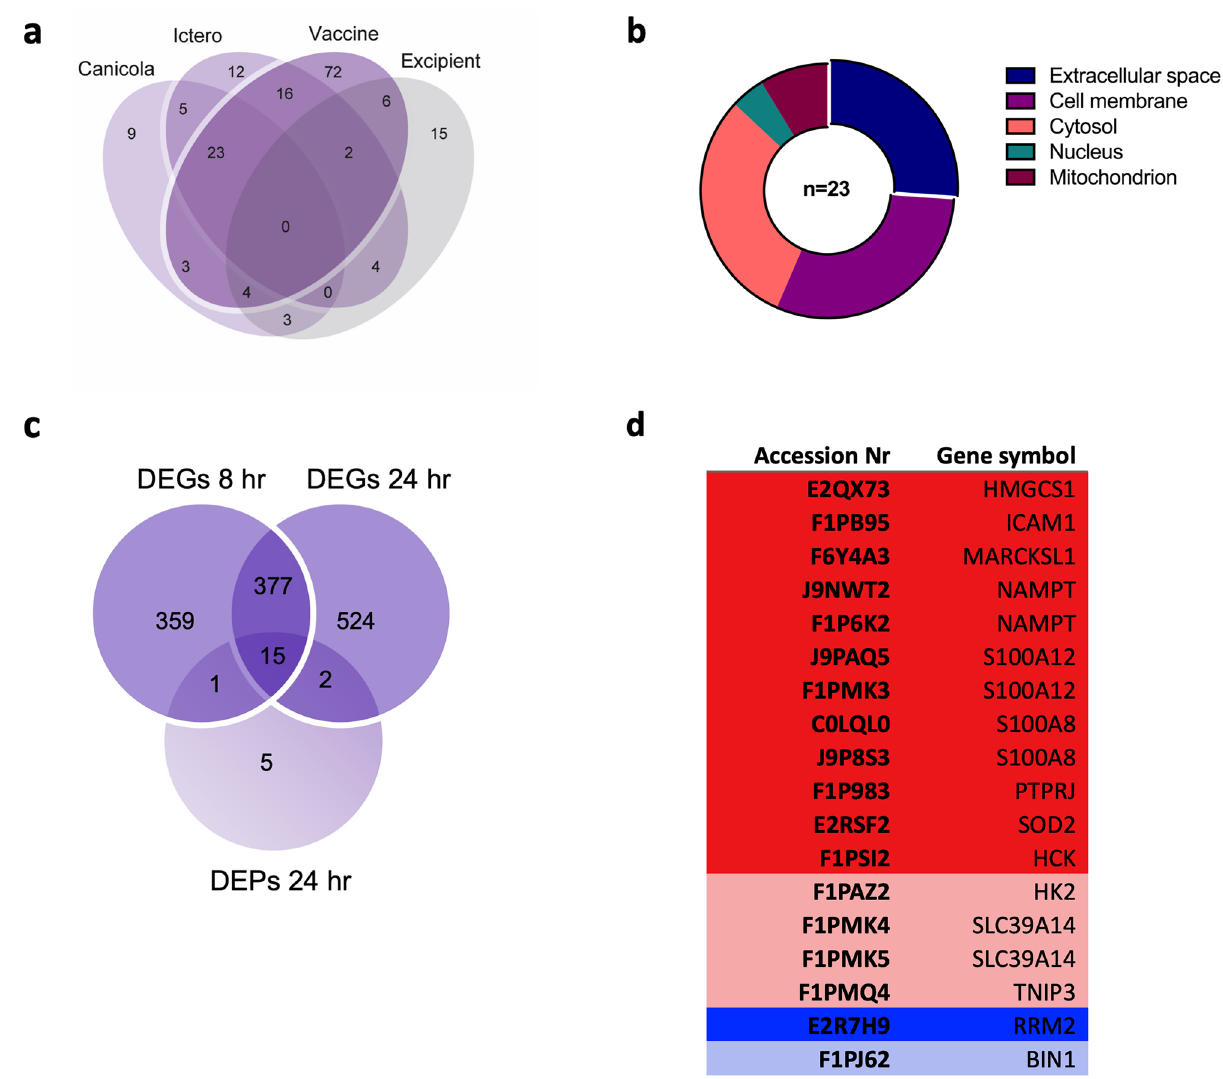
Figure 3. Analysis of the proteome of 030-D cells stimulated with the inactivated L. interrogans serogroup Canicola or Icterohaemorrhagiae or bivalent Leptospira vaccine B. ( a ) Venn diagram of DEPs found after 24 h stimulation with the inactivated L. interrogans serogroup Canicola or Icterohaemorrhagiae, bivalent Leptospira vaccine, or vaccine excipient as non-antigen control (all manufacturer B). Proteins were considered quantitative DEPs if found in at least two of the triplicates, showed at least twofold change in expression compared to unstimulated control (FC ≥ 2) and reached statistical significance (P < 0.01). Additionally, proteins were considered qualitative DEPs if found 3 × in the stimulated sample and absent in the unstimulated sample or the other way round. ( b ) Overview of the subcellular localization of 23 DEPs that were found after stimulation with the inactivated Leptospira strains and bivalent vaccine. ( c ) Venn diagram showing that 18 of the 23 DEPs found after 24 h stimulation with both Leptospira strains and the vaccine were also found on the transcriptome level at 8 and 24 h. ( d ) These 18 DEPs common to all three stimuli correspond to 14 unique genes. Upregulated DEPs are shown in red and downregulated DEPs in blue. DEPs found with quantitative analysis are indicated with bright colors, while DEPs found with qualitative analysis are indicated with dim